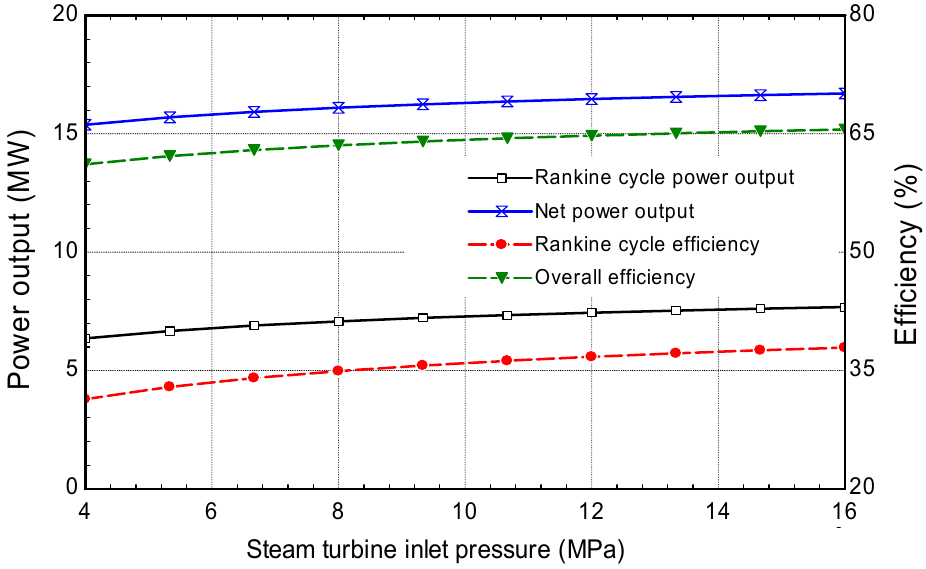
Figure 4. Impact of varying the inlet pressure of the steam turbine on the Rankine cycle output power, Rankine cycle efficiency, net power output, and the efficiency of the overall system.